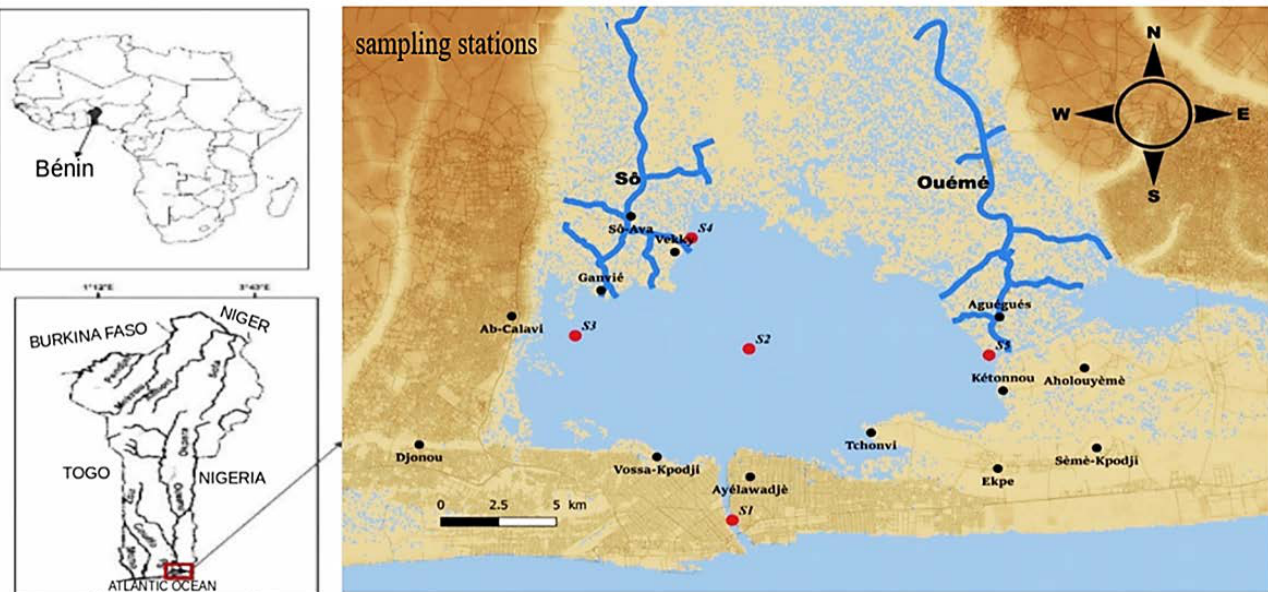
Figure 1. Geographical location of Lake Nokoué in West Africa, south of Benin. The red dots indicate the stations.